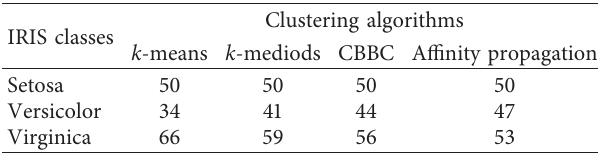
Table 7: Ratings predicted for the active user. Table 8: Clustering performance on IRIS dataset by the proposed algorithm and baseline algorithms.